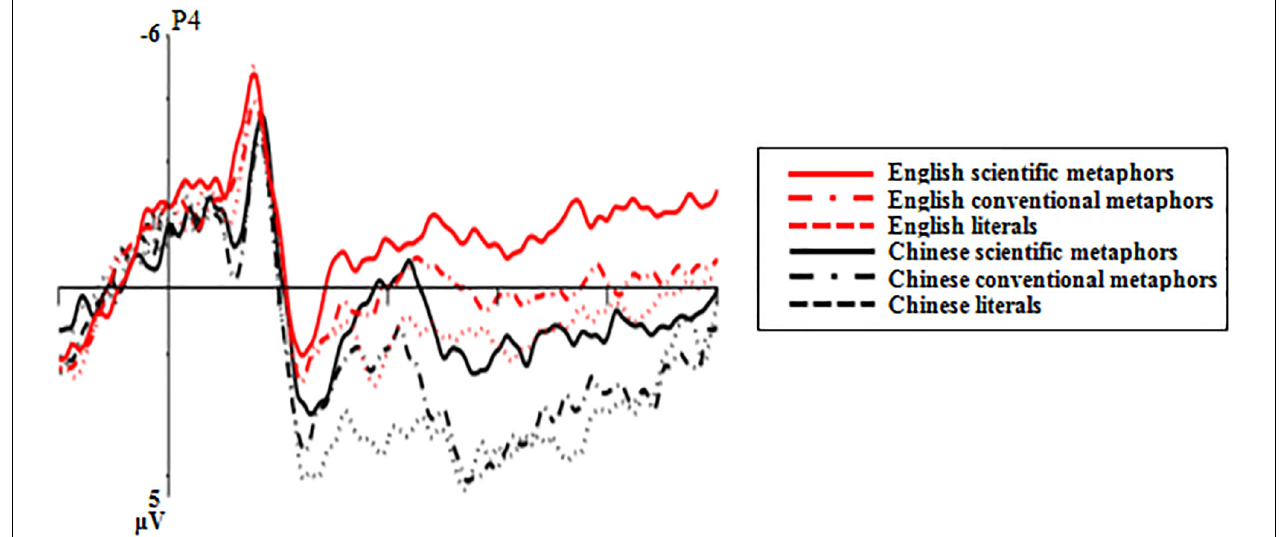
FIGURE 7 | Grand average ERP waveforms of Chinese and English stimuli recorded at the P4 electrode position.